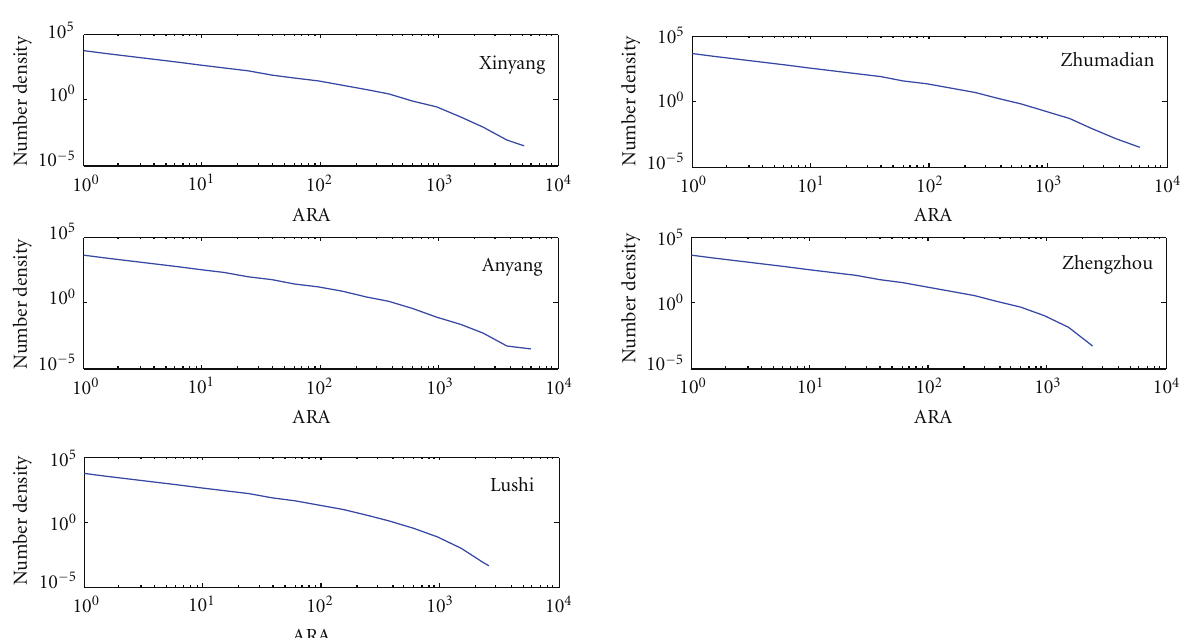
Figure 5: Log-log plot of the probability number density for accumulated rain